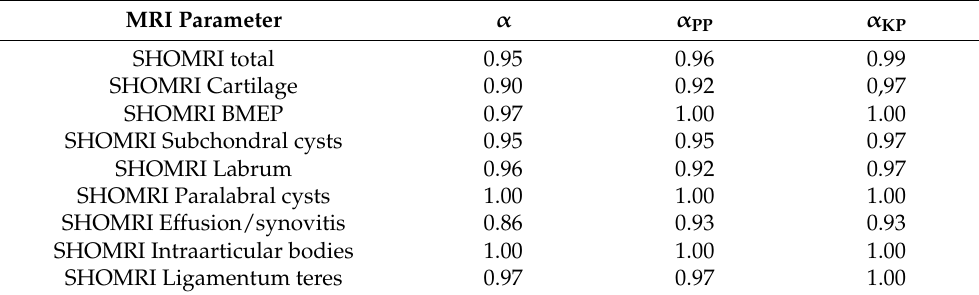
Table 3. Inter-reader and intra-reader agreement.